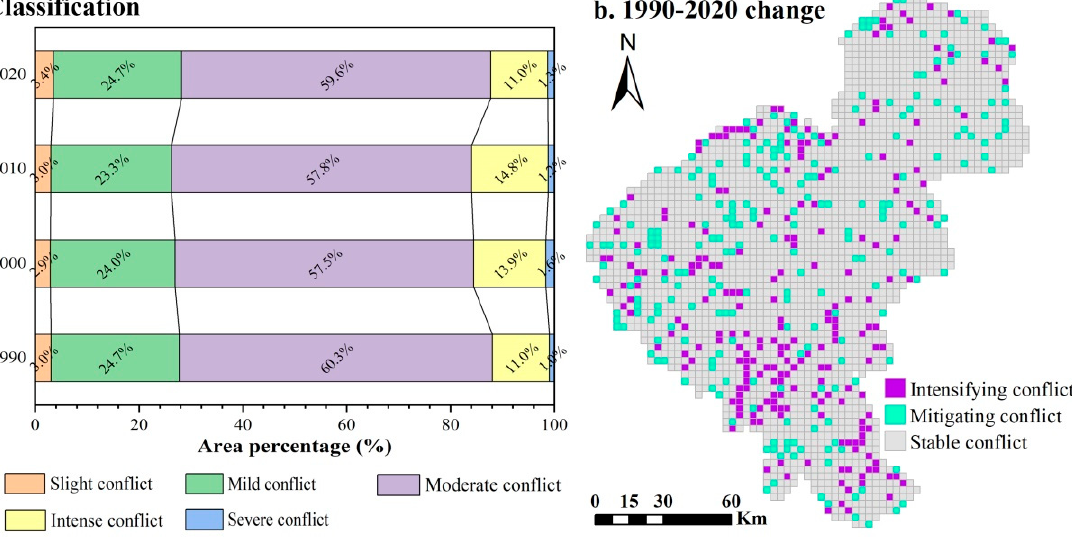
Figure 7. Types of land use conflict ( a ) and spatial patterns of conflict changes ( b ) from 1990 to 2020.